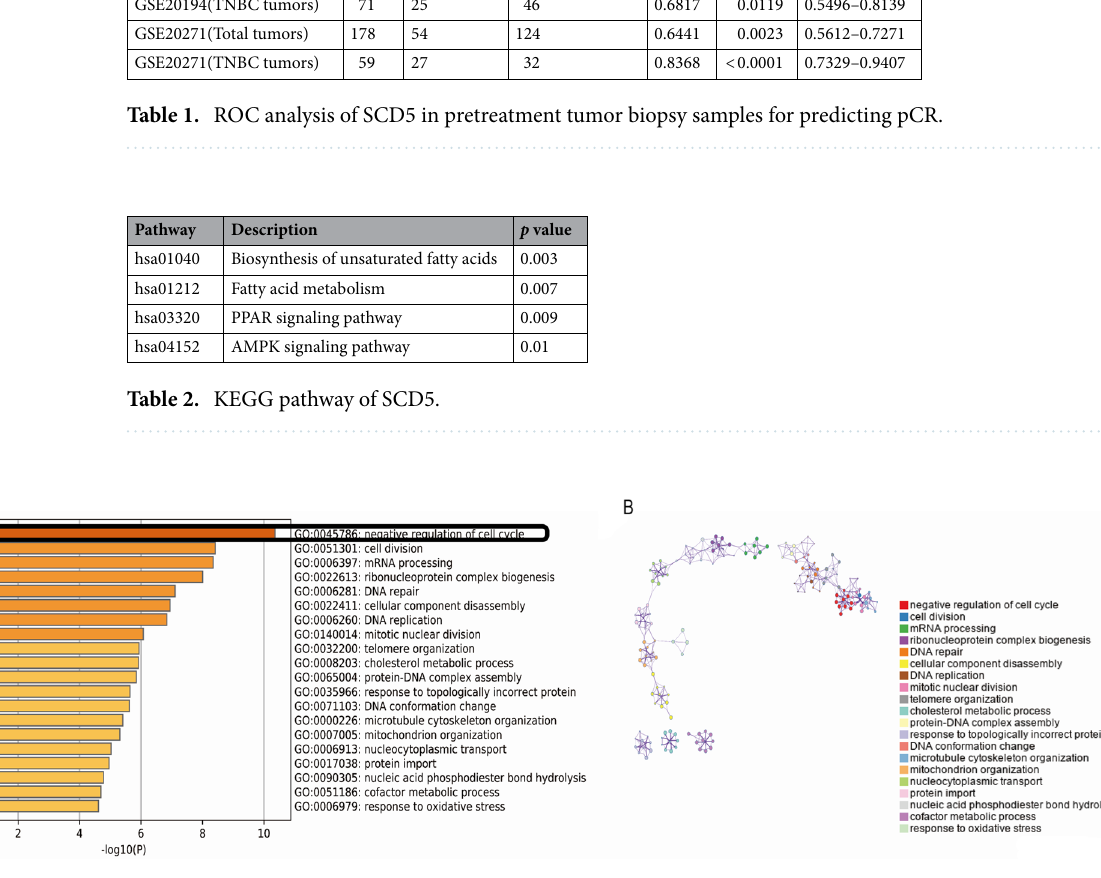
Figure 6. GO annotation and functional enrichment of SCD5-related differential expressed genes (DEGs). ( A ) GO biological process analysis of SCD5-related DEGs was performed by using Metascape with the criteria of p value < 0.01. ( B ) Network plot of the relationships among GO terms. Nodes represented enriched terms colored by its cluster